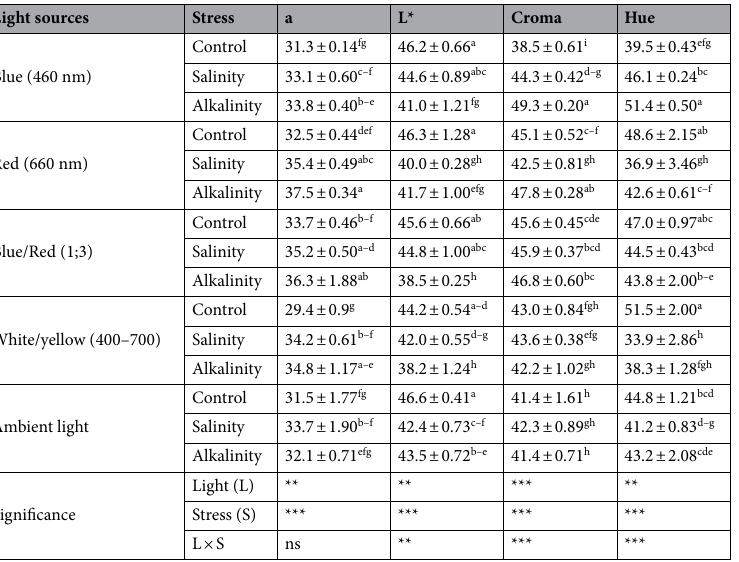
Table 5. Interaction of five levels of light spectrum and three levels of stress treatment on fruit color parameters of strawberry cv. Camarosa. Values are means ± SE of three replicates. Bars with different letters show significant differences at P ≤ 0.05 (Duncan). Significance according to ANOVA, ns, *, **, ***, no significant and significant P ≤ 0.05, 0.01, 0.001, respectively. Control (no stress), salinity (80 mM NaCl) and alkalinity (40 mM NaHCO 3 ). Photon flux density (PPFD) 200 ± 10 mmol_m –2 s –1 . SAS software version 9.4 was used for data analysis.